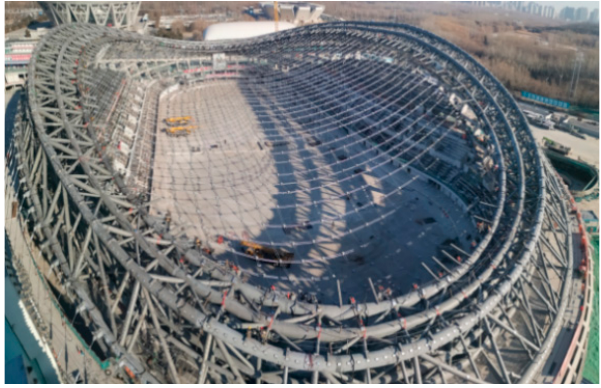
Figure 6. Construction site of speed skating hall.